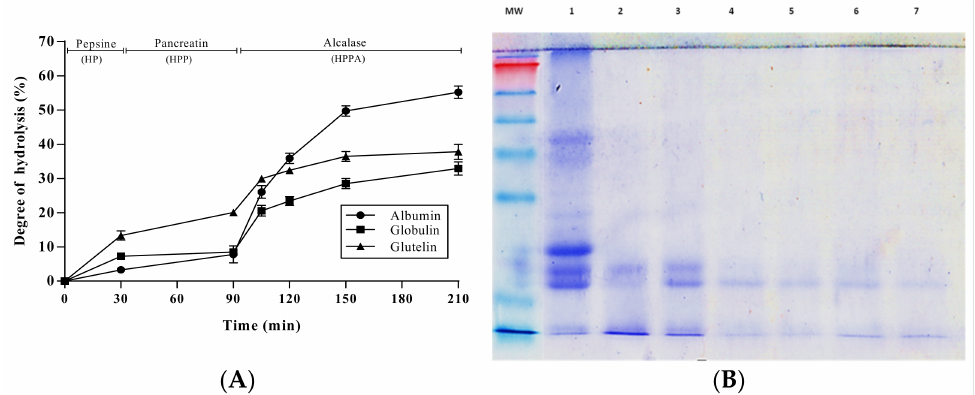
Figure 2. ( A ) Degree of hydrolysis (%) of the hydrolyzates from Erythrina edulis (pajuro) seed-derived albumin, globulin, and glutelin fractions after the action of pepsin for 30 min (PH), pepsin 30 min + pancreatin 60 min (PPH), and pepsin 30 min + pancreatin 60 min + Alcalase at different times (PPHA15, PPHA30, PPHA60, and PPH120). ( B ) SDS-PAGE analysis of (1) Erythrina edulis (pajuro) seed albumin fraction; (2) hydrolyzate by pepsin for 30 min (PH); (3) hydrolyzate by pepsin for 30 min and pancreatin for 60 min (PPH); (4) hydrolyzate by pepsin for 30 min, pancreatin for 60 min, and Alcalase for 15 min (PPHA15); (5) hydrolyzate by pepsin for 30 min, pancreatin for 60 min, and Alcalase for 30 min (PPHA30); (6) hydrolyzate by pepsin for 30 min, pancreatin for 60 min, and Alcalase for 60 min (PPHA60); (7) hydrolyzate by pepsin for 30 min, pancreatin for 60 min, and Alcalase for 120 min (PPHA120). MW: molecular weight marker SeeBlue™ Plus2 Prestained. Moreover, the DH of glutelin PPH was higher to that described for the kanihua- derived glutelin fraction hydrolyzed for 2 h with both digestive enzymes (15.0%)